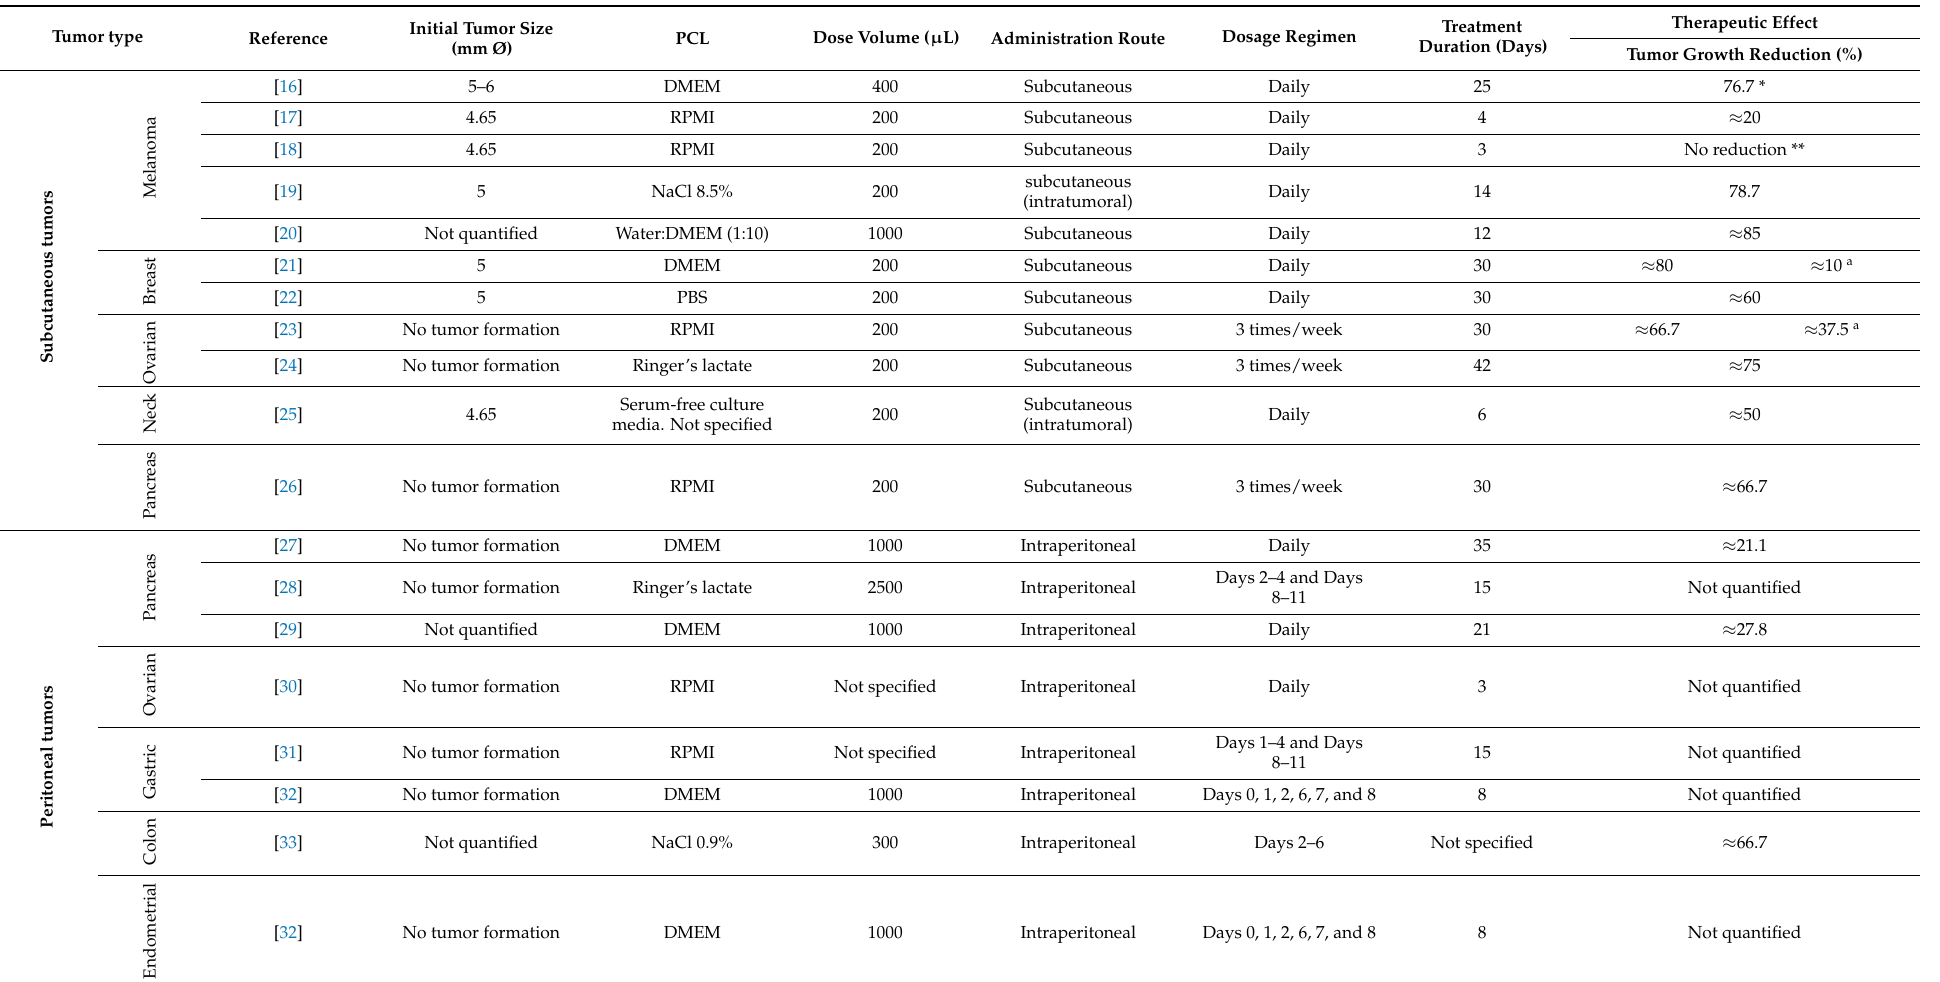
Table 2. Therapeutic effects of PCL in vivo. Influence of initial tumor size, dosage regimen, and treatment duration on tumor growth reduction for different types of cancer. Tumor